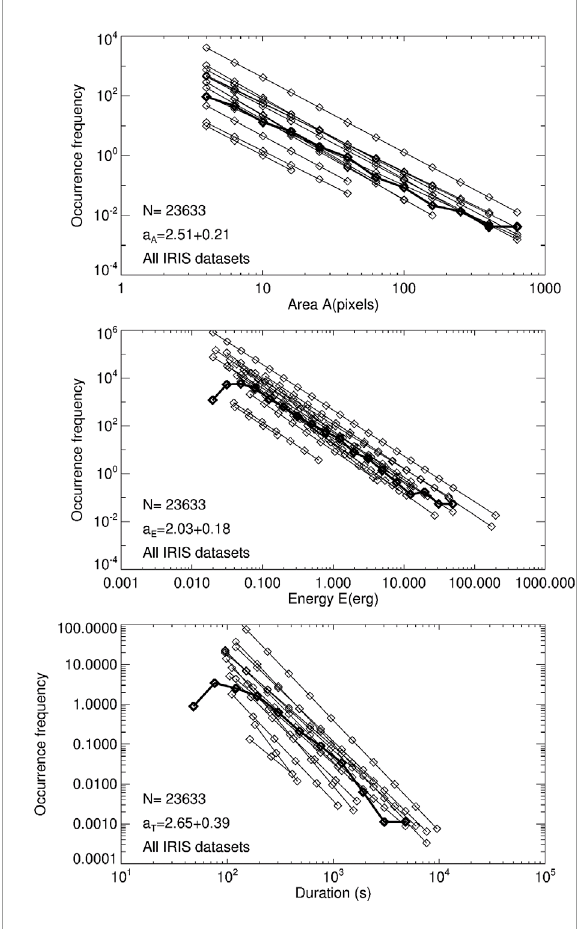
FIGURE 2 Power law fits to the size distributions of three SOC parameters: the event area A (top panel), the radiative energy E (middle panel), and the time duration (bottom panel). Individual fits to each of the 12 IRIS datasets are indicated with thin line style, while the fit to all events combined is indicated with thick line style, and the power law slopes are given in each panel.